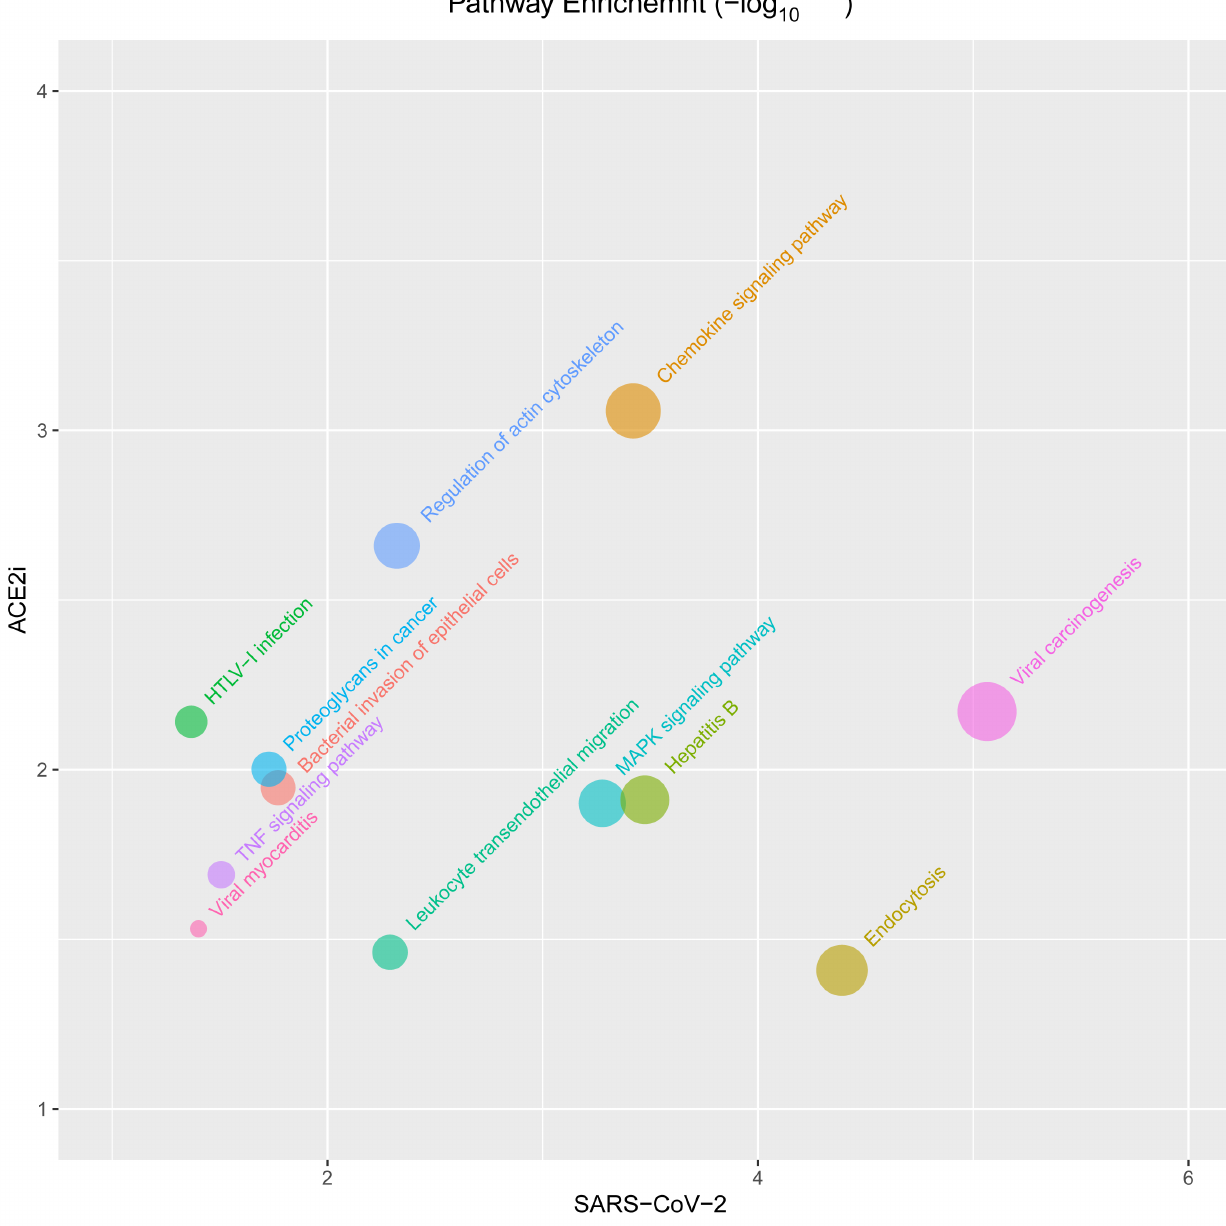
multiple pathways involved in virus infection are